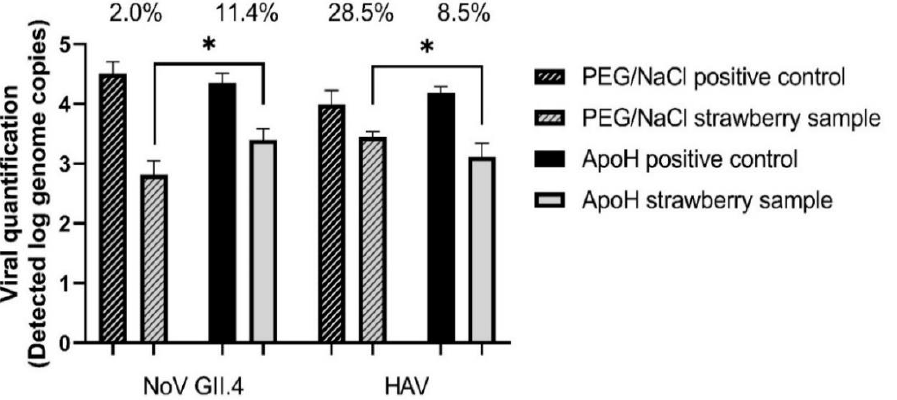
Figure 1. Simultaneous detection of HAV and NoV GII.4 on fresh strawberries using PEG/NaCl or ApoH beads to concentrate the viruses. Initial viral load at 1 × 10 4 genome copies/sample for HAV and at 1 × 10 5 genome copies/sample for NoV GII.4. Asterisk indicates statistically significant differences ( p ≤ 0.05) between viral recuperation of ApoH method and ISO method based on the unpaired , two tailed t -test.